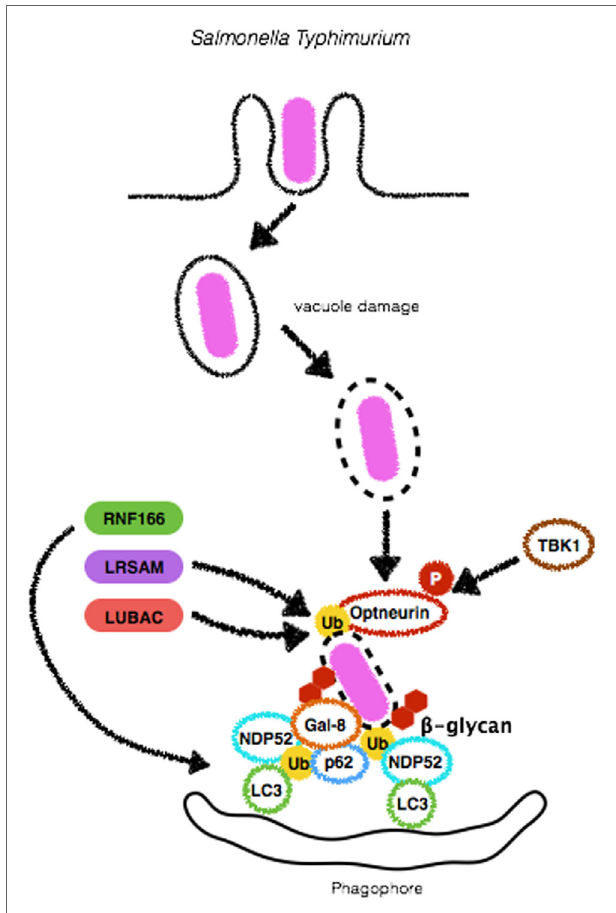
FigURe 4 | Mechanisms of autophagy induction by Salmonella Typhimurium . Upon entry in epithelial cells, S. Typhimurium resides in a specialized compartment, the Salmonella-containing vacuole (SCV). A fraction of the bacterial population damages and/or escapes from SCV and initiates to replicate in the cytosol. Either still within the SCV or free in the cytosolic compartment, S. Typhimurium triggers autophagy by several means. β -glycan present in vacuole remnants is recognized by Galectin-8 (Gal-8) and targets bacteria to autophagosomes. S. Typhimurium can also be ubiquitinated by the E3-ligases LRSAM or LUBAC, allowing its recognition by autophagic adaptors Optneurin, p62 or NDP52. RNF166, another E3-ligase, ubiquitinates p62 to increase the ability of this protein to bind bacteria-associated ubiquitin. Diacylglycerol (DAG) recognition and autophagy induction upon S. Typhimurium infection are not depicted